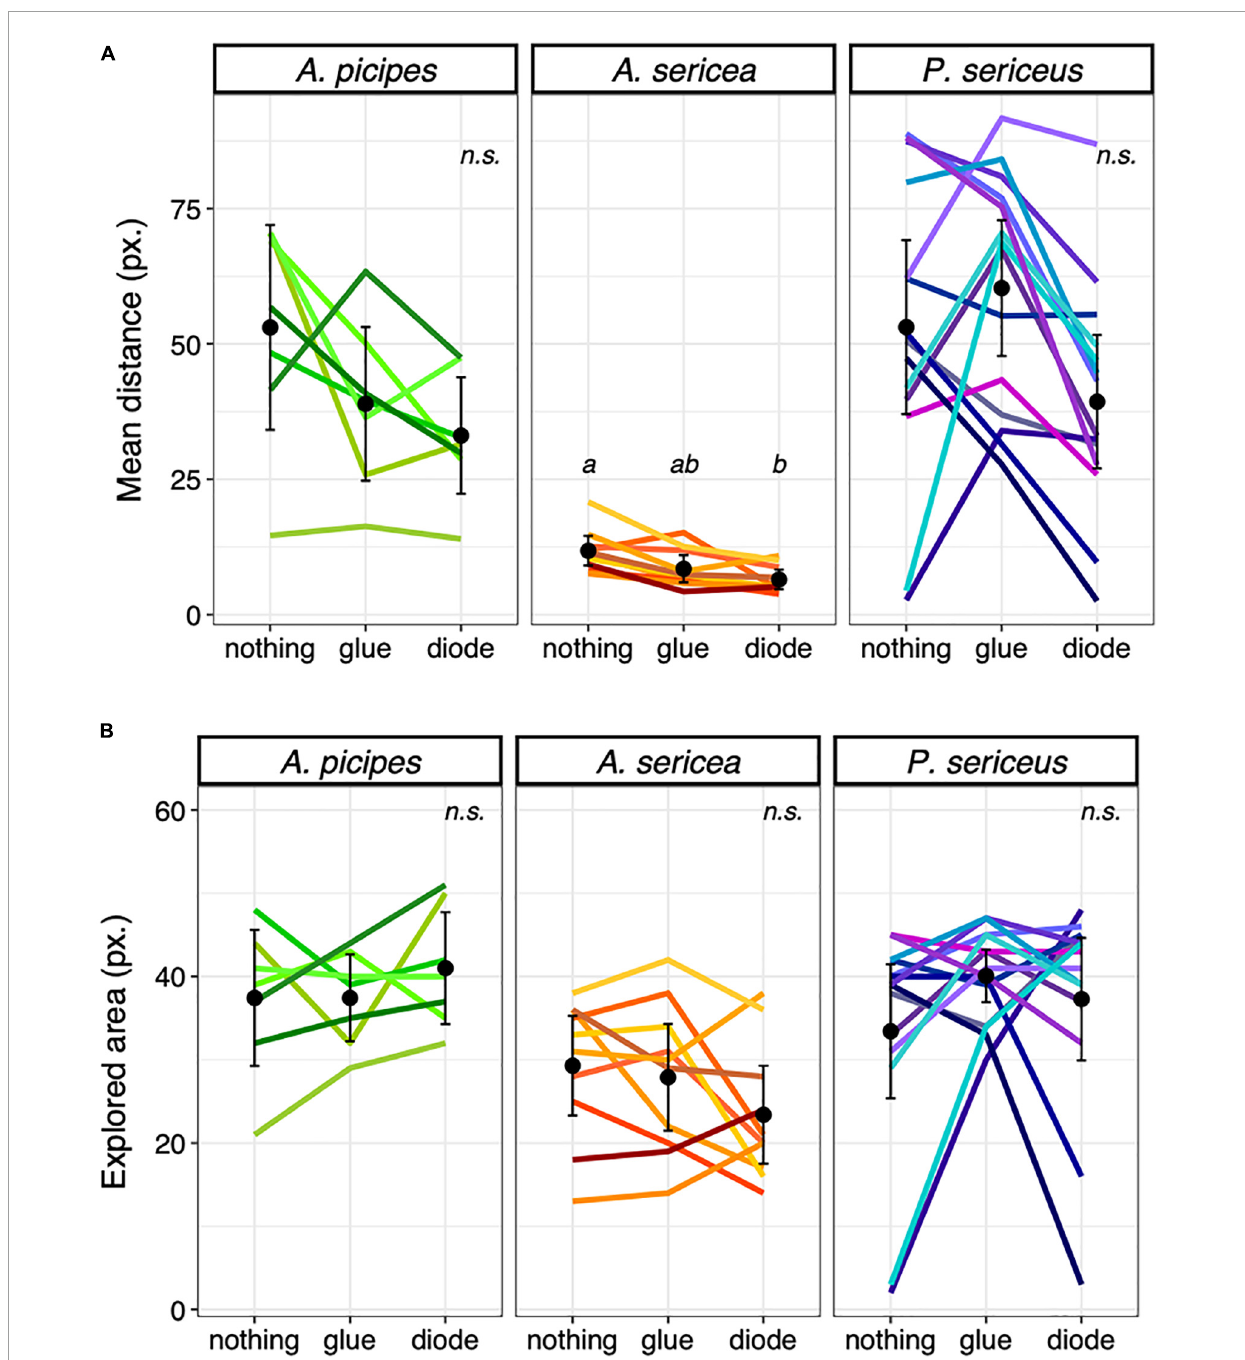
FIGURE4 Effect of the diode, (A) Mean distance ( ± SE) travelled per time step among species and runs in the arena in pixels and (B) Mean explored area ( ± SE) among species and runs in the arena. Different letters indicate significant differences between runs ( P < 0.05), n.s. = non-significant. Each coloured line represents an